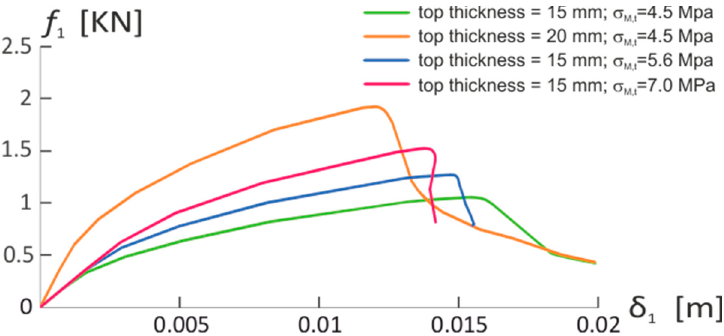
Figure 10. Force-displacement curves for different thicknesses of the table top and different maximum tensile stress σ M,t (see Figure 4).